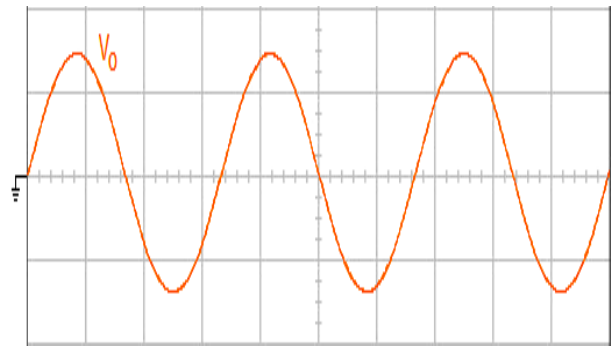
of output voltage and reference sine wave (100 V/div; 5 ms/div).